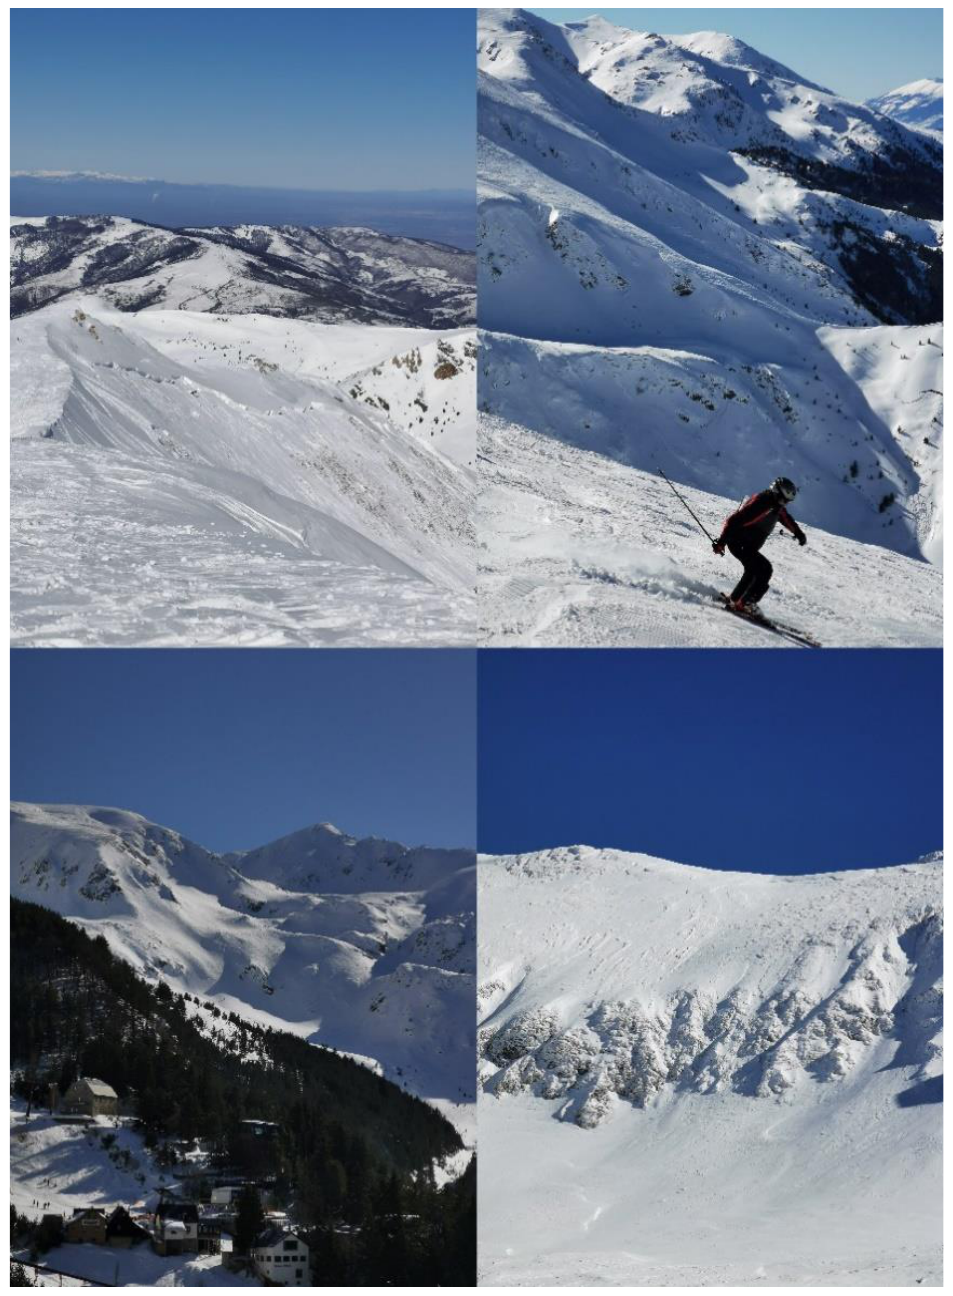
Figure 2. Ski center Brezovica on the Šar Mountains (photo by Jovanović, S., 2022) . According to the Institute for Nature Conservation of Serbia, the Šar Mountains have one of the highest degrees of biodiversity in Europe: 1800 plant species (of which 339 are endemic to the Balkan and 18 are endemic to the Šar Mountains), 147 species of butterflies, 200 species of birds and about 45 species of reptiles and amphibians inhabit this mountain massif